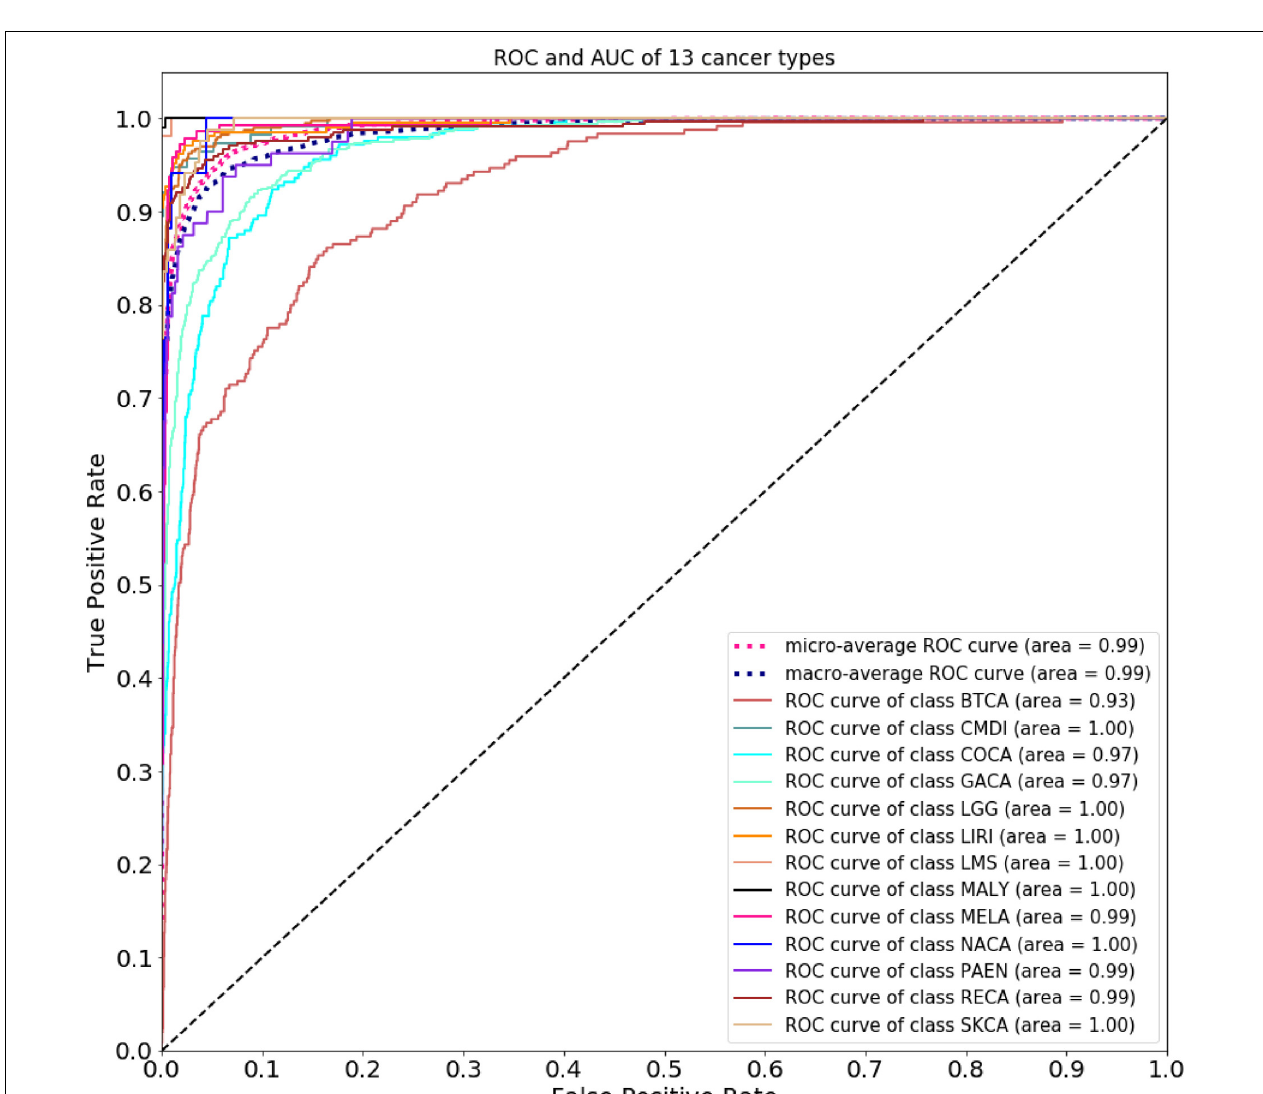
FIGURE 4 | Receiver operating characteristic curve and AUC of 13 types of